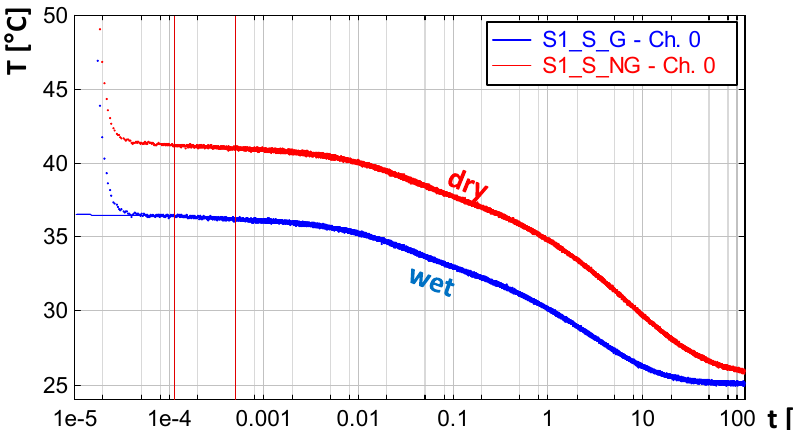
Figure 14. The recorded voltage transient converted to temperature change using the mapping of Figure 12.